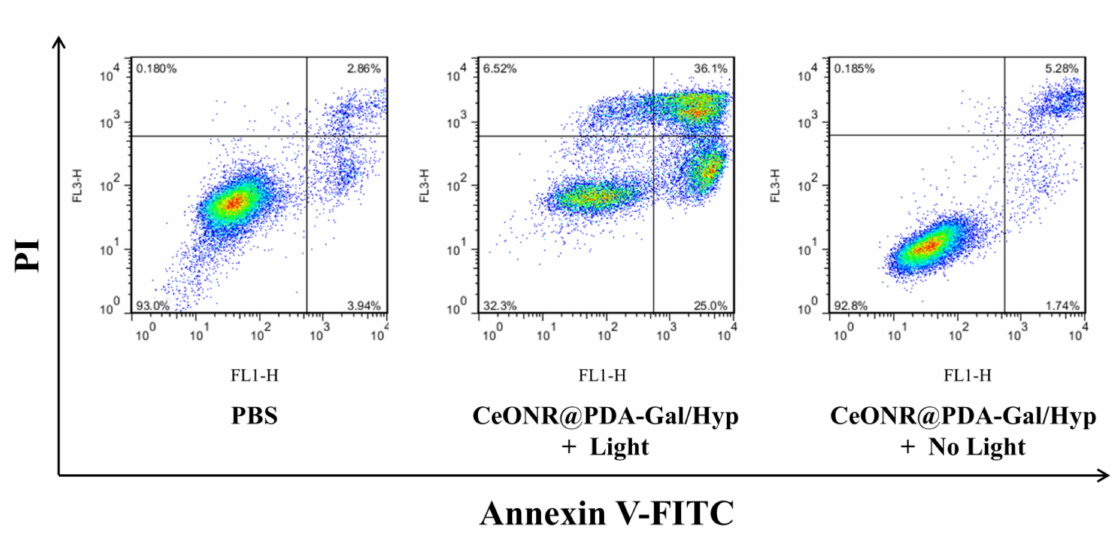
Figure 8. The cell death and apoptosis of HepG2 cells after staining with annexin V–FITC and propidium iodide (PI) by flow